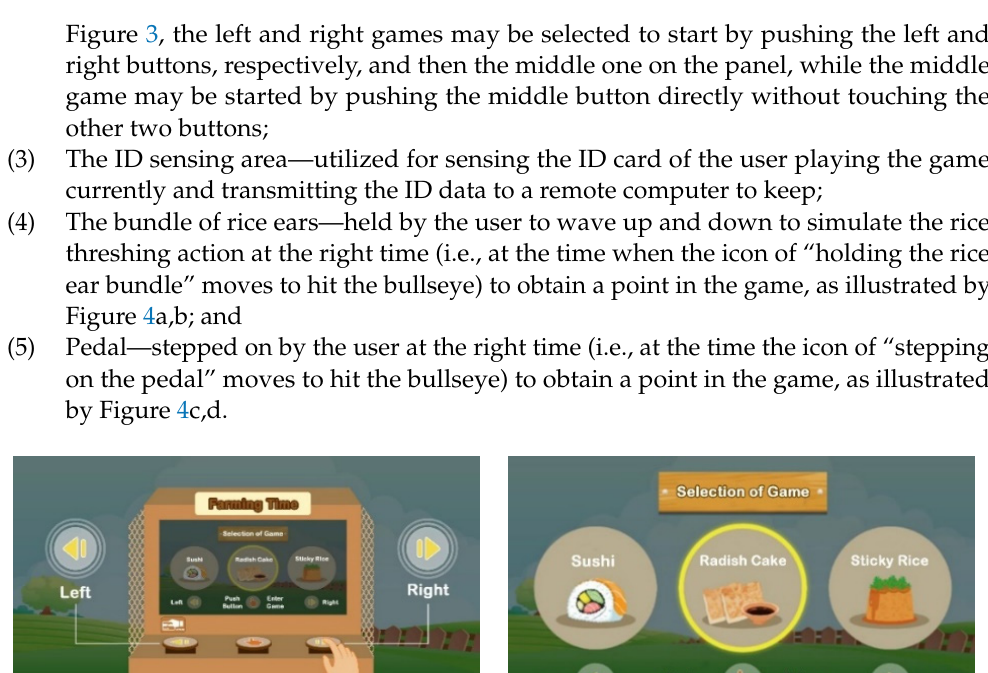
( b ) Figure 2. Real old-time pedal-operated rice threshing machines. ( a ) A machine with a complete view [73]. ( b ) Another machine with a closer view [74] (Note: the rice grains are removed away from the rice ears by a roller with nails on the surface, whose rotation is controlled by a pedal stepped on by the farmer). Seen from the exterior, the system as shown in Figure 1b consists of a display screen, a tangible panel with buttons, an ID sensing area, a bundle of rice ears (shown on top of the system), and a pedal (shown below the panel), whose functions are described in the